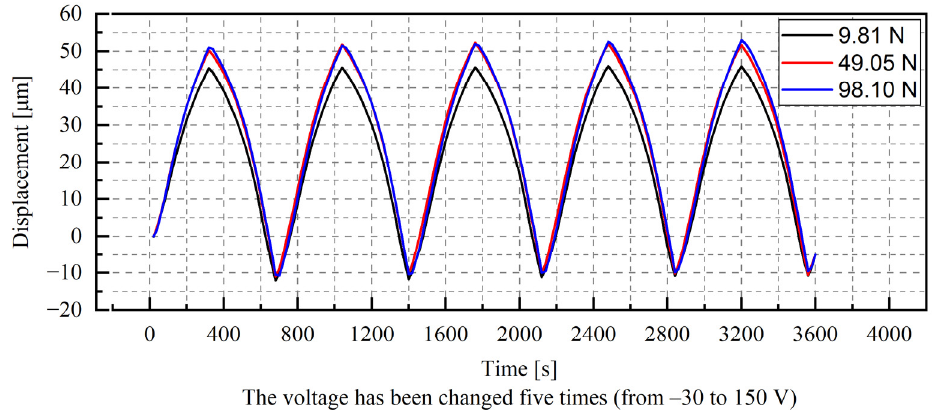
Figure 5. Results of the quasi-static test for different preload